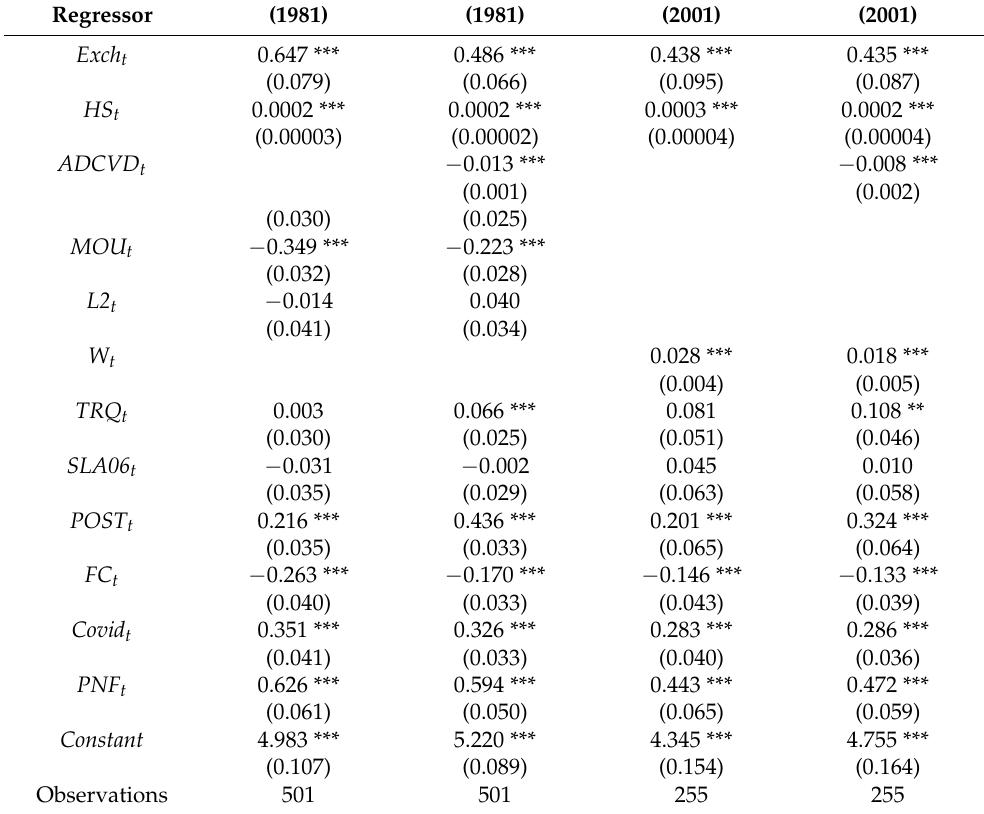
Table 4. Explaining North American lumber price movements: dependent variable logarithm of composite price